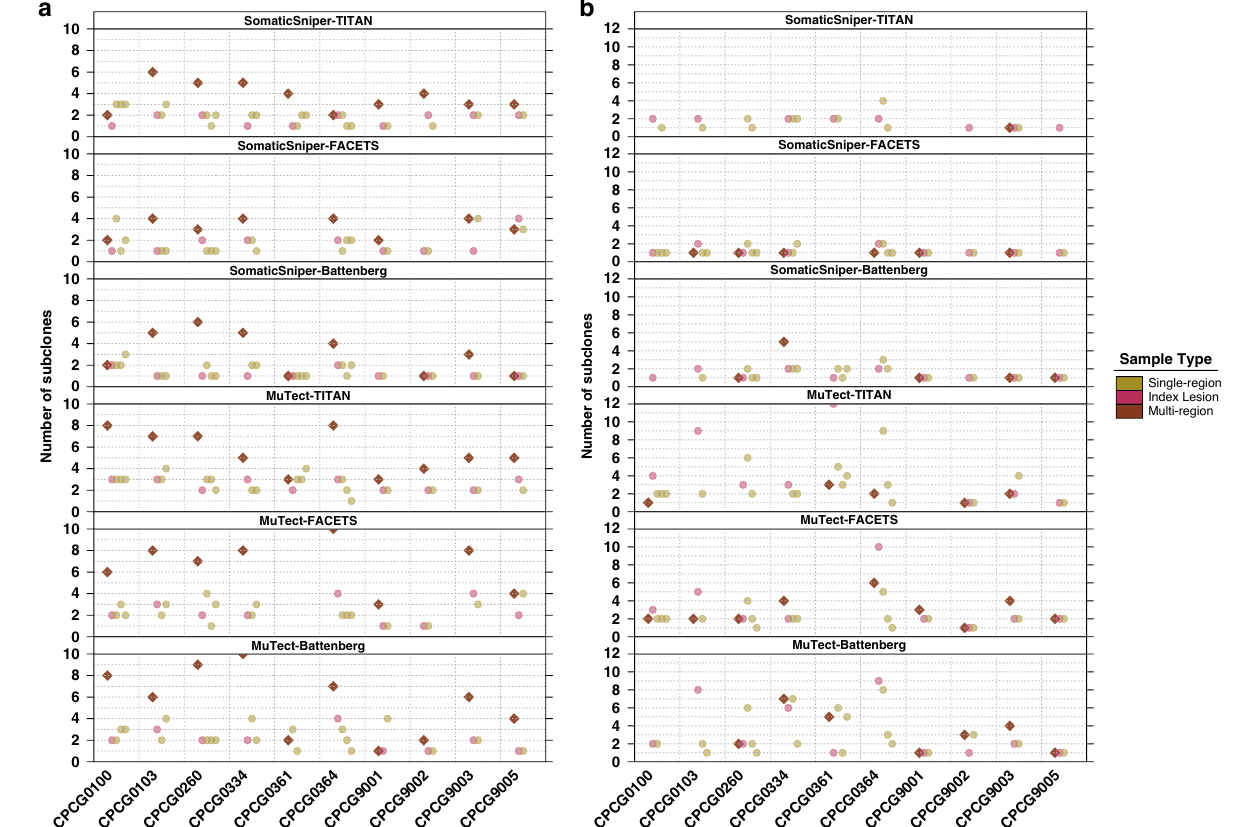
Fig. 6 Single-region reconstructions predict fewer subclones than multi-region reconstructions. Number of subclones predicted for each tumour from multi-region reconstruction (brown diamond) and reconstructions of each of the individual regions (circle), including the index lesion (pink circle) by pipelines using a PhyloWGS and b PyClone. Missing values indicate a failed reconstruction. Multi-region reconstruction SomaticSniper-TITAN-PhyloWGS: n = 10 biologically independent samples; SomaticSniper-FACETS-PhyloWGS: n = 8; SomaticSniper-Battenberg-PhyloWGS: n = 9; MuTect-TITAN- PhyloWGS: n = 10; MuTect-FACETS-PhyloWGS: n = 8; MuTect-Battenberg-PhyloWGS: n = 10; SomaticSniper-TITAN-PyClone: n = 1; SomaticSniper- FACETS-PyClone: n = 6; SomaticSniper-Battenberg-PyClone: n = 5; MuTect-TITAN-PyClone: n = 5; MuTect-FACETS-PyClone: n = 9; MuTect-Battenberg- PyClone: n = 7. Single-region reconstruction SomaticSniper-TITAN-PhyloWGS: n = 30; SomaticSniper-FACETS-PhyloWGS: n = 26; SomaticSniper- Battenberg-PhyloWGS: n = 30; MuTect-TITAN-PhyloWGS: n = 30; MuTect-FACETS-PhyloWGS: n = 26; MuTect-Battenberg-PhyloWGS: n = 28; SomaticSniper-TITAN-PyClone: n = 18; SomaticSniper-FACETS-PyClone: n = 26; SomaticSniper-Battenberg-PyClone: n = 25; MuTect-TITAN-PyClone: n = 25; MuTect-FACETS-PyClone: n = 25; MuTect-Battenberg-PyClone: n =